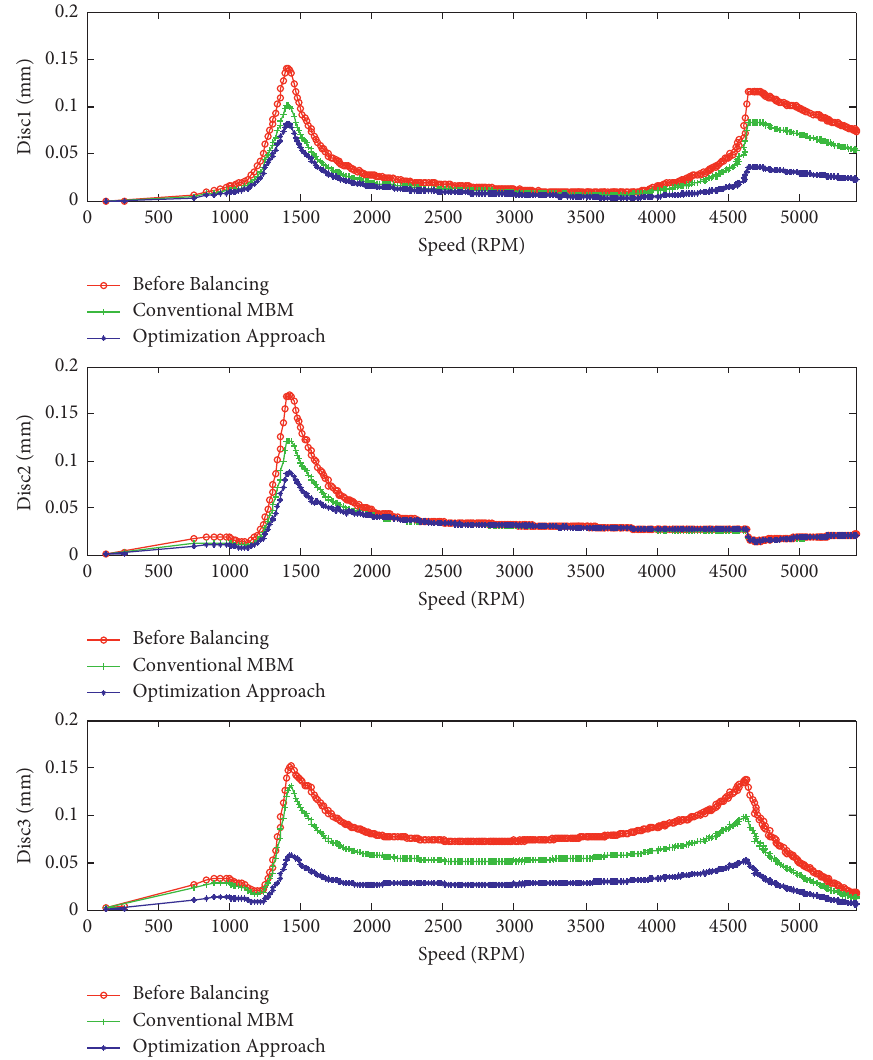
Figure 12: Vibration response of three discs during speeding